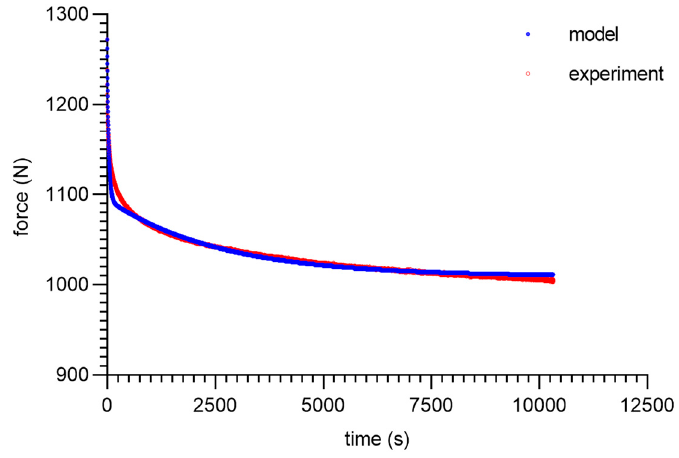
Figure 8. Material 80 ShA— fi ve-parameter relaxation model and experimental data for ε = 25% .